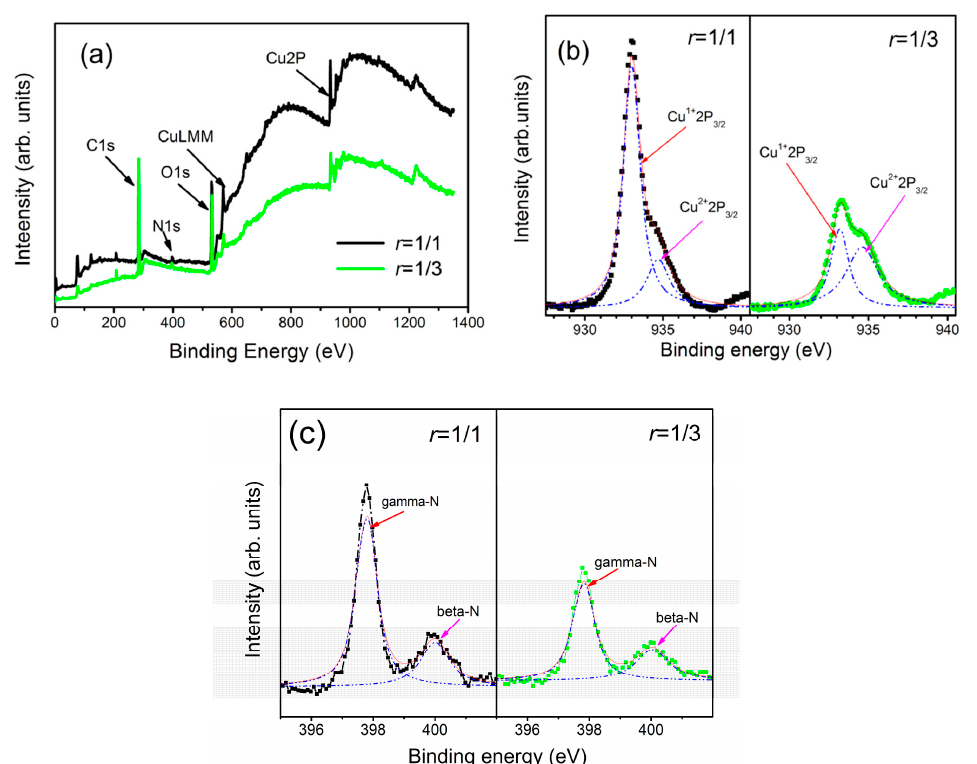
Figure 4. XPS spectra of Cu 3 N films deposited by r = 1/1 and r = 1/3: ( a ) Survey, ( b ) deconvoluted Cu2p spectra, and ( c ) deconvoluted N1s spectra.